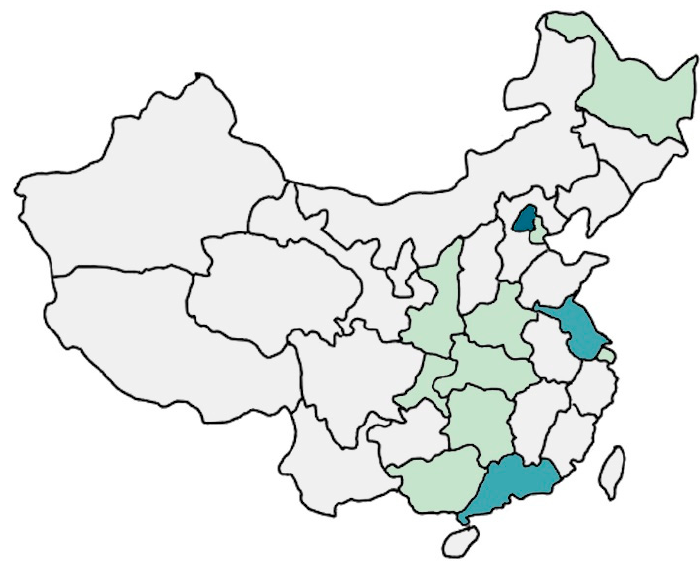
Figure 1. Wastewater treatment companies registered in the distribution.